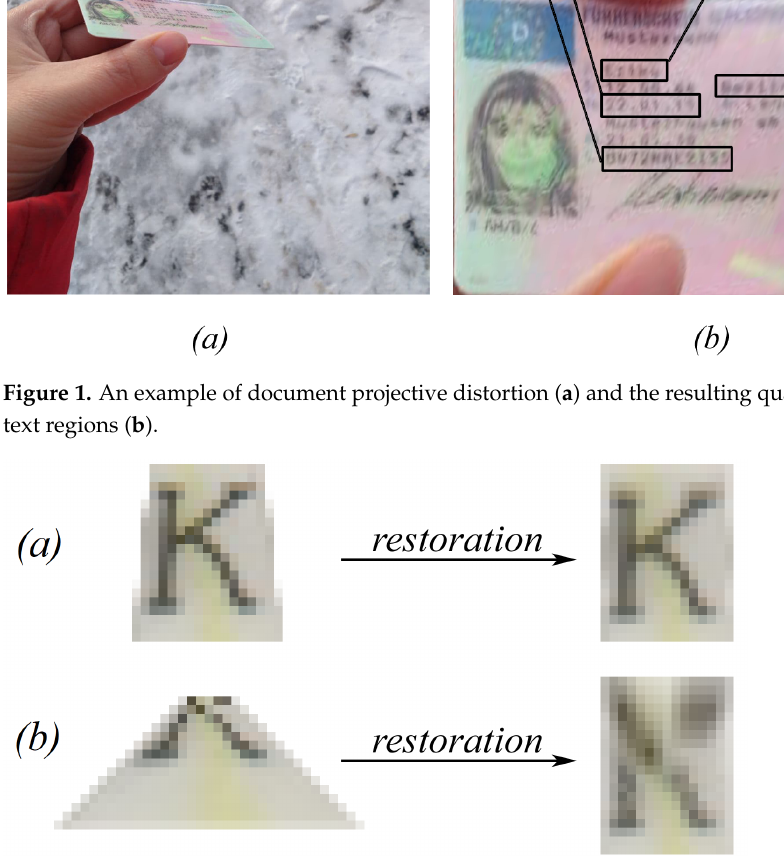
Figure 2. Restoration results of ( a ) a slightly projectively distorted image and ( b ) a highly distorted image of equal area. Restoration was conducted with bilinear